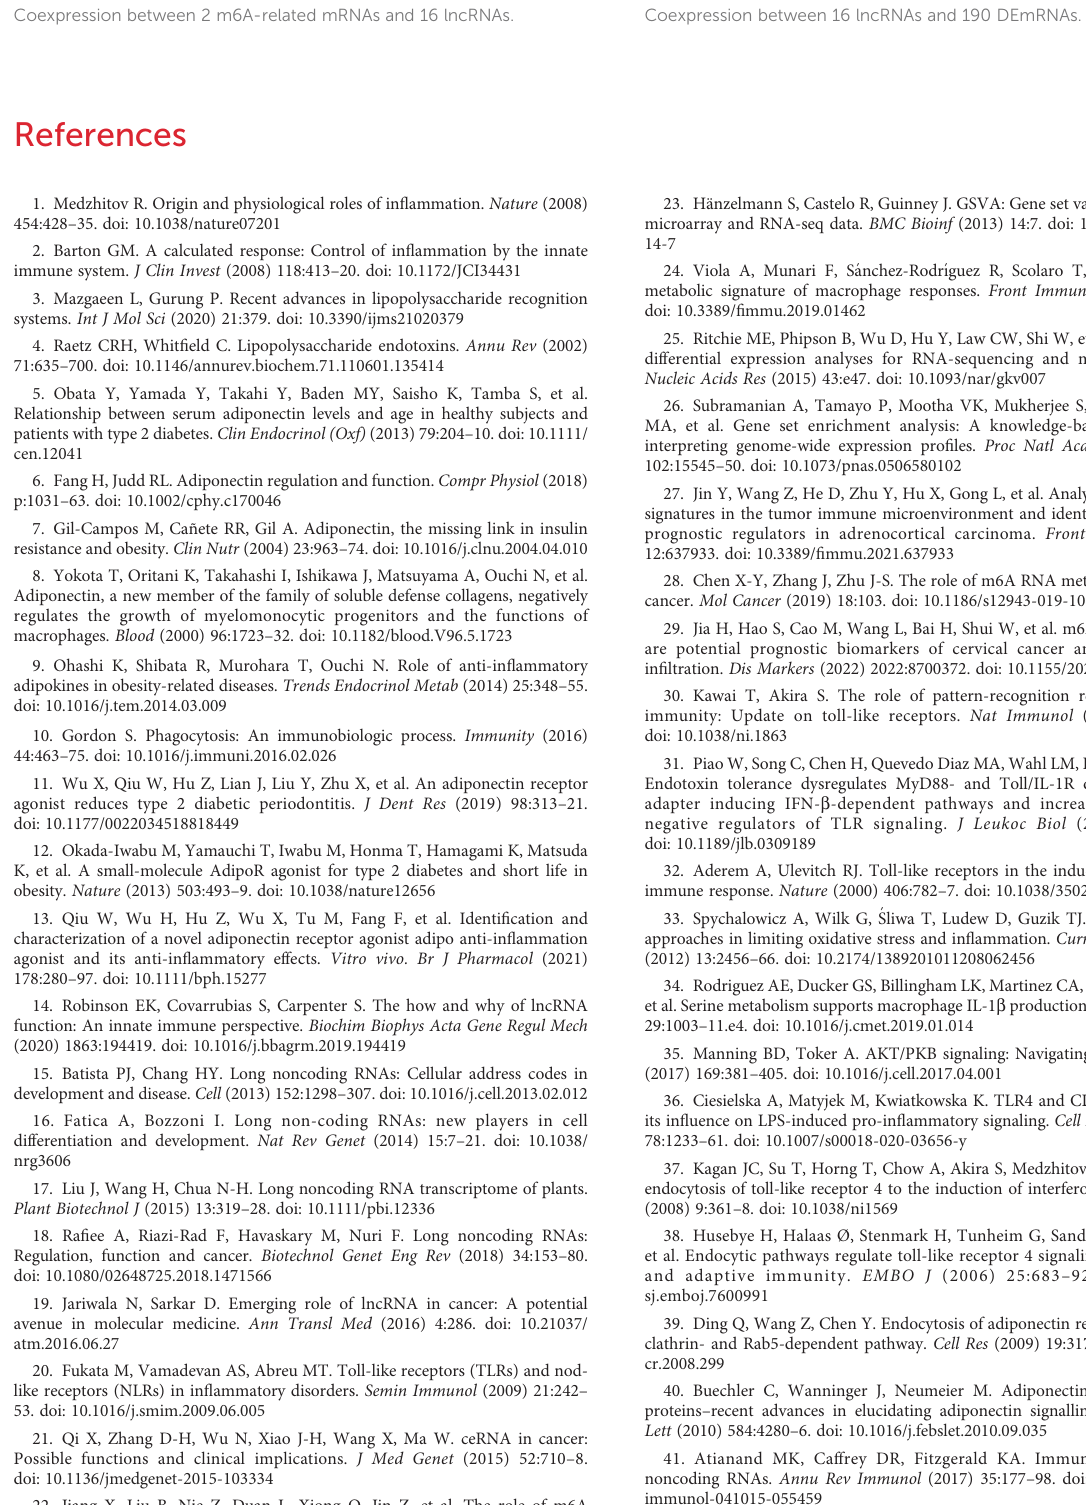
SUPPLEMENTARY FIGURE 7 Coexpression between 2 m6A-related mRNAs and 190 DEmRNAs. SUPPLEMENTARY FIGURE 8 Coexpression between 16 lncRNAs and 190